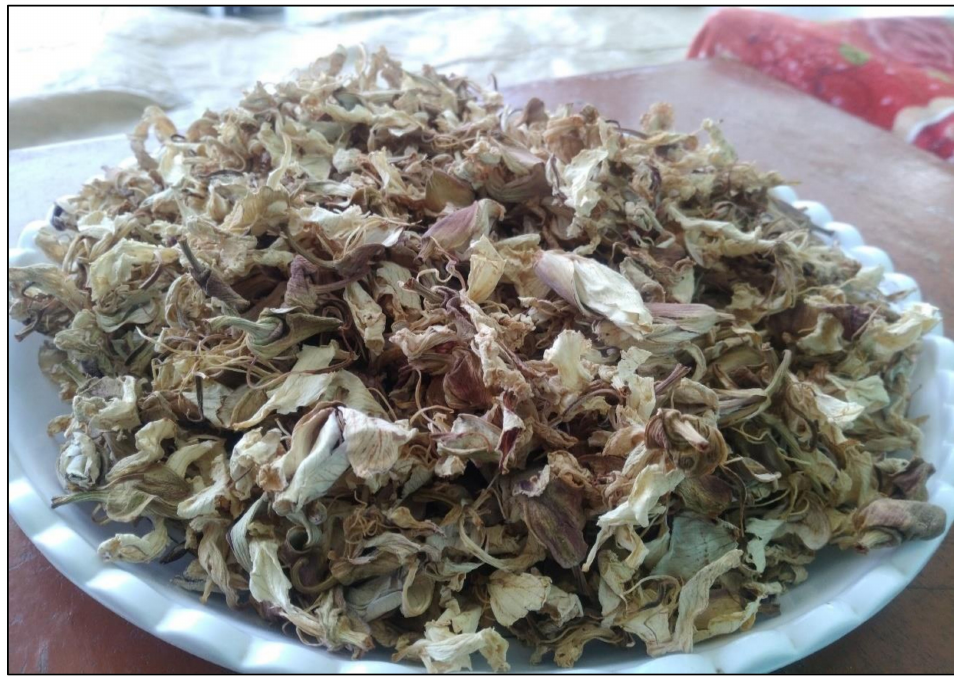
Figure 6. Dried flowers of Bauhinia variegata